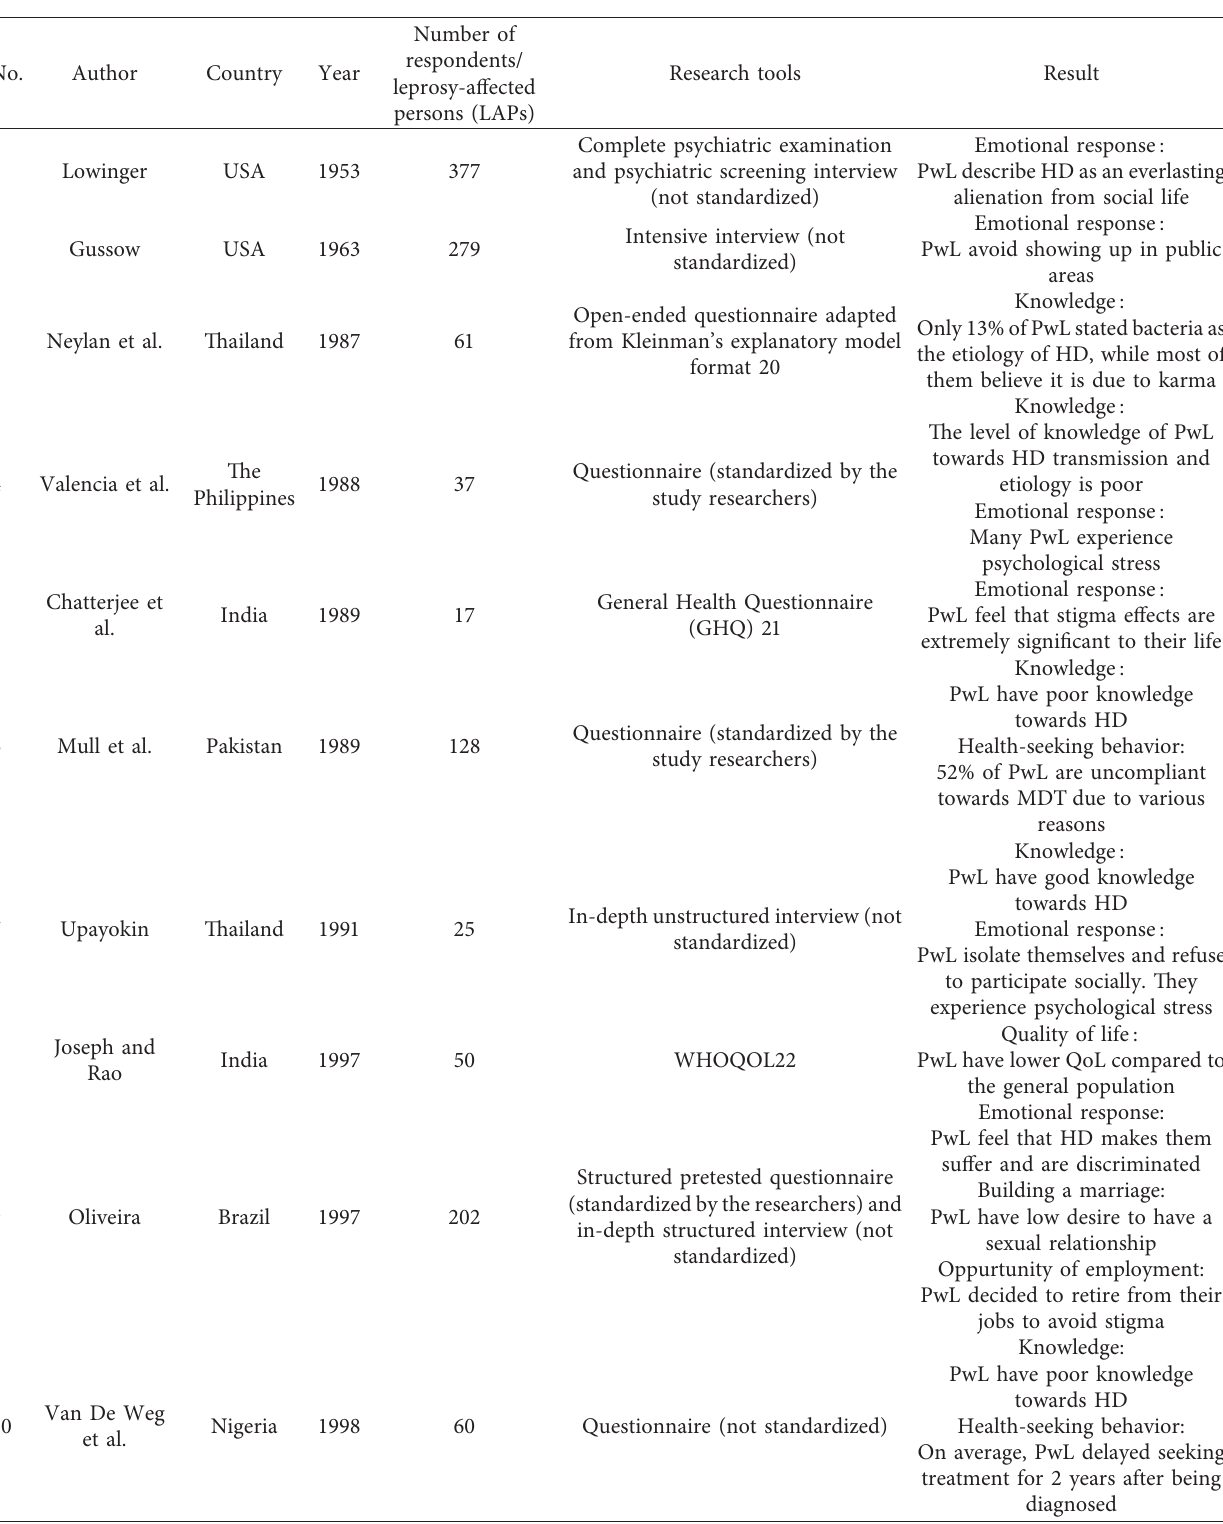
Table 1: Articles included in the